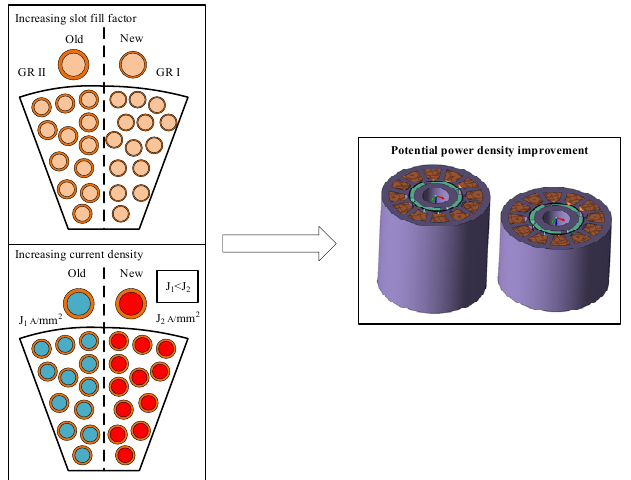
Figure 17. Potential performance improvement by adopting ROD.